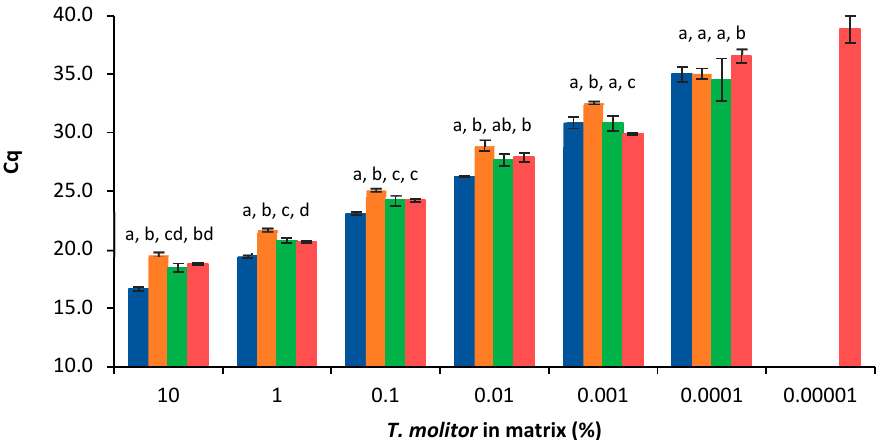
Figure 3. Comparison of the dynamic range of the calibration curves obtained by real-time PCR targeting cytochrome b gene according to the type of thermal treatment and food matrix (mean ± SD of n = 8 replicates from 2 independent runs). Different letters for the same spiking level mean statistically significant differences between matrices ( p < 0.05) following ordinary one-way ANOVA or ANOVA analysis.